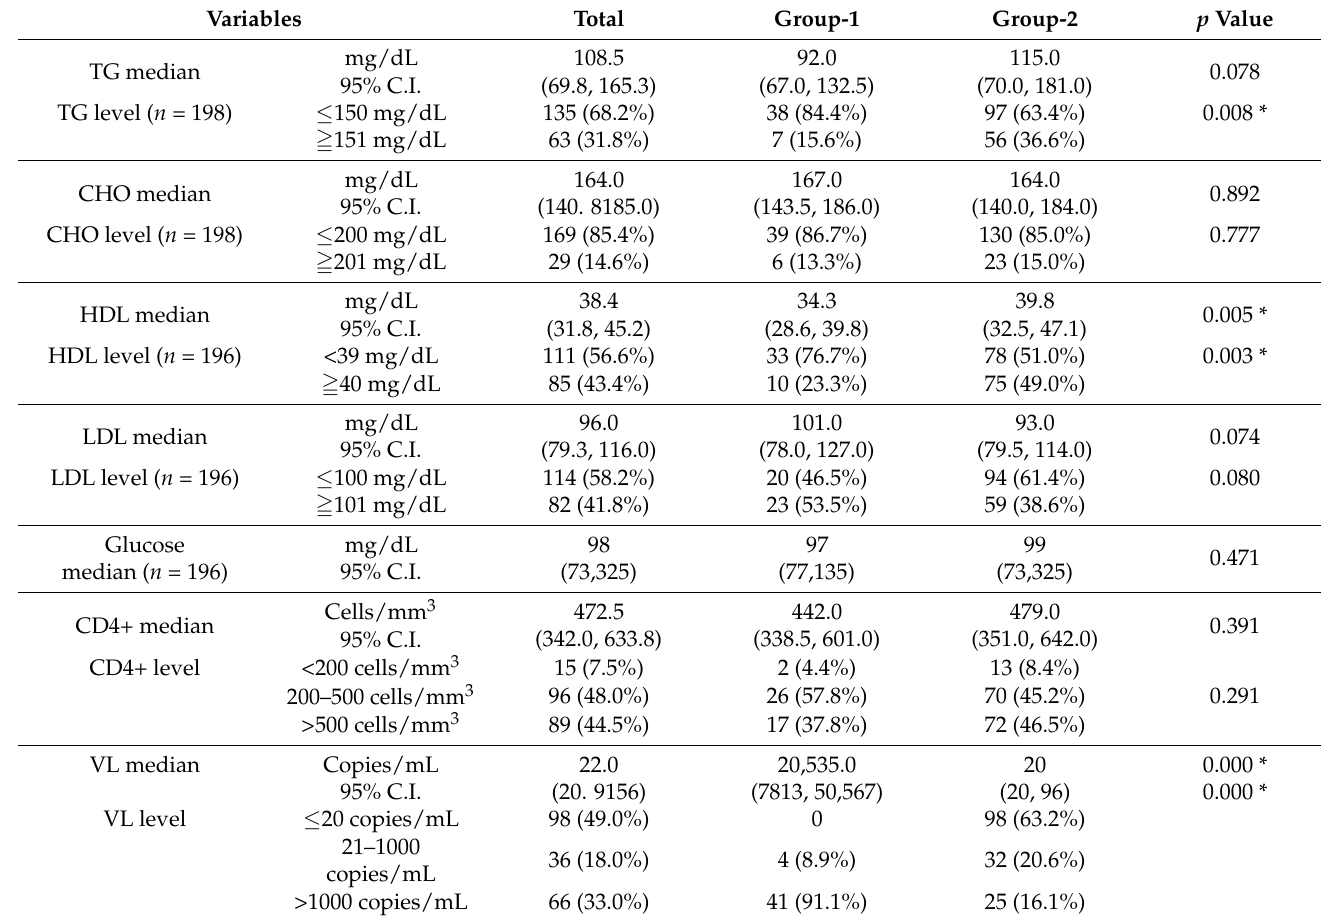
Table 3. Laboratory variables of the participants ( n =